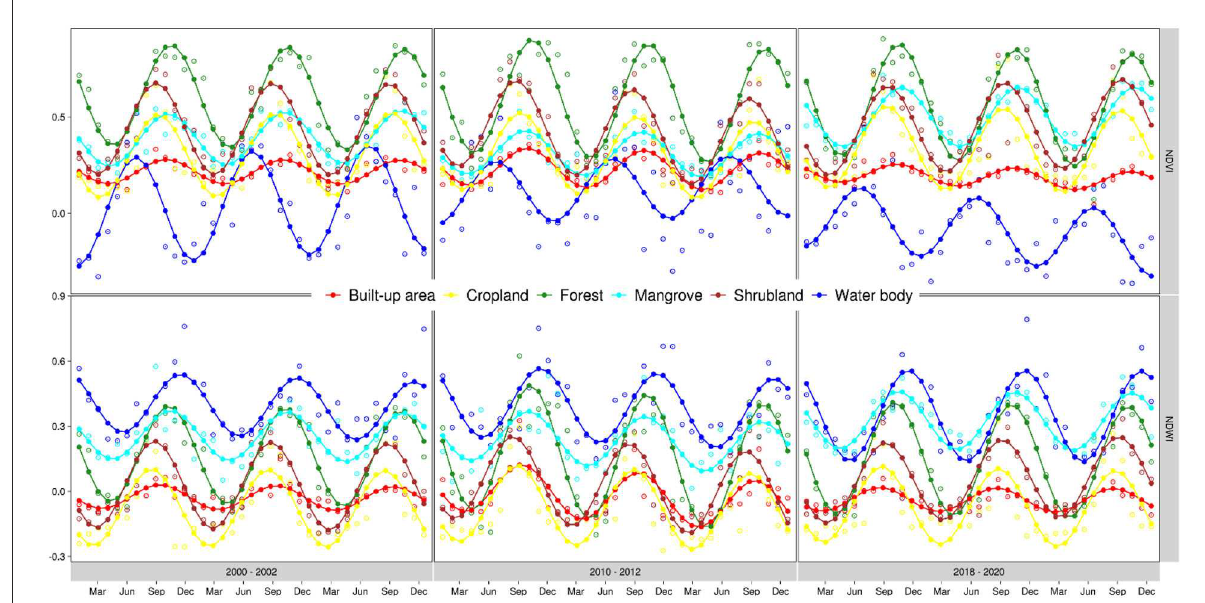
FIGURE3 Available monthly median Landsat NDVI and Gao NDWI values after MODIS gap filling, and their corresponding gap-filled and predicted values estimated using harmonic modeling at a different location in The Gambia. This figure illustrates how the model fits different data inputs to capture the variations across multiple pixels. Non-solid circles represent the raw Landsat data after gap-filling using MODIS data. Dots (inside non-solid circles) represent gap-filled data after harmonic modeling. Solid circles are fitted values after harmonic modeling. Non-solid circles without a dot inside are noisy data detected and removed by the harmonic prior to computing the fitted